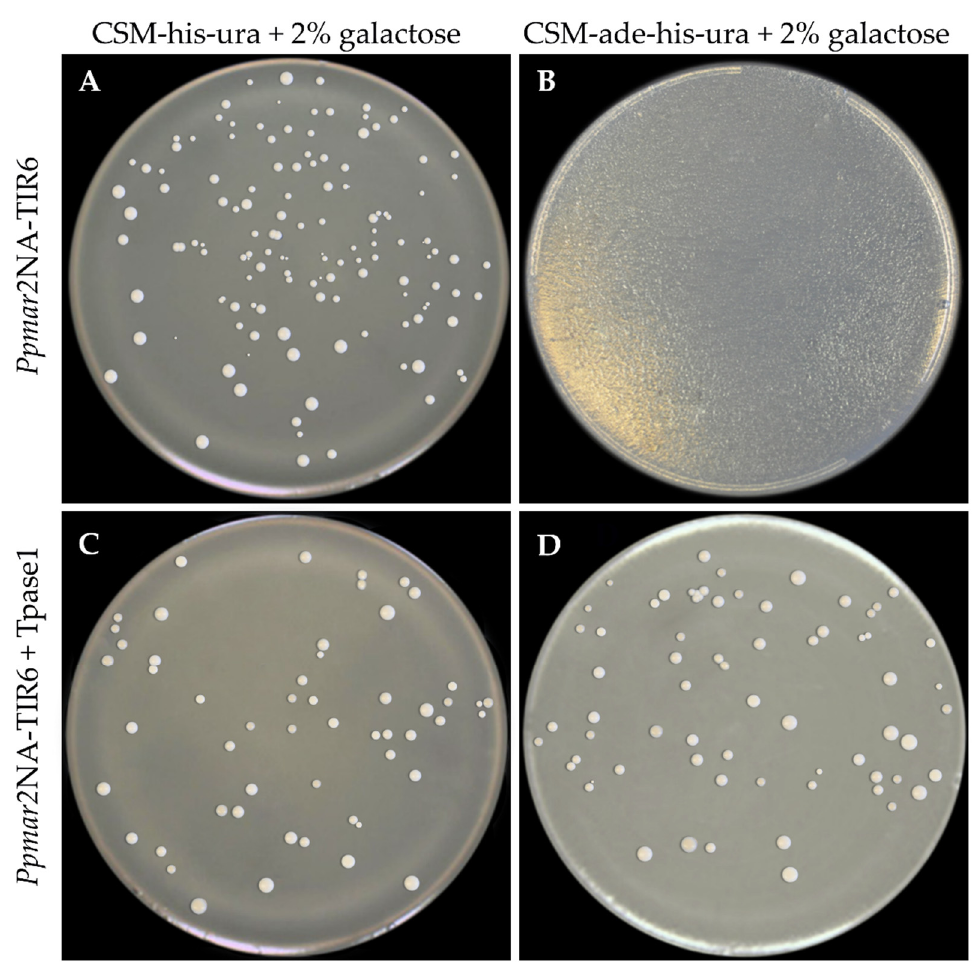
Figure 4. Yeast transformation assay for the active mutant TIR Ppmar2NA- TIR6, showing active colony growth in the presence of adenine, irrespective of the presence of Ppmar1 transposase (Tpase1) ( A , transposase absent; C , transposase present). When grown on adenine free medium, no colonies